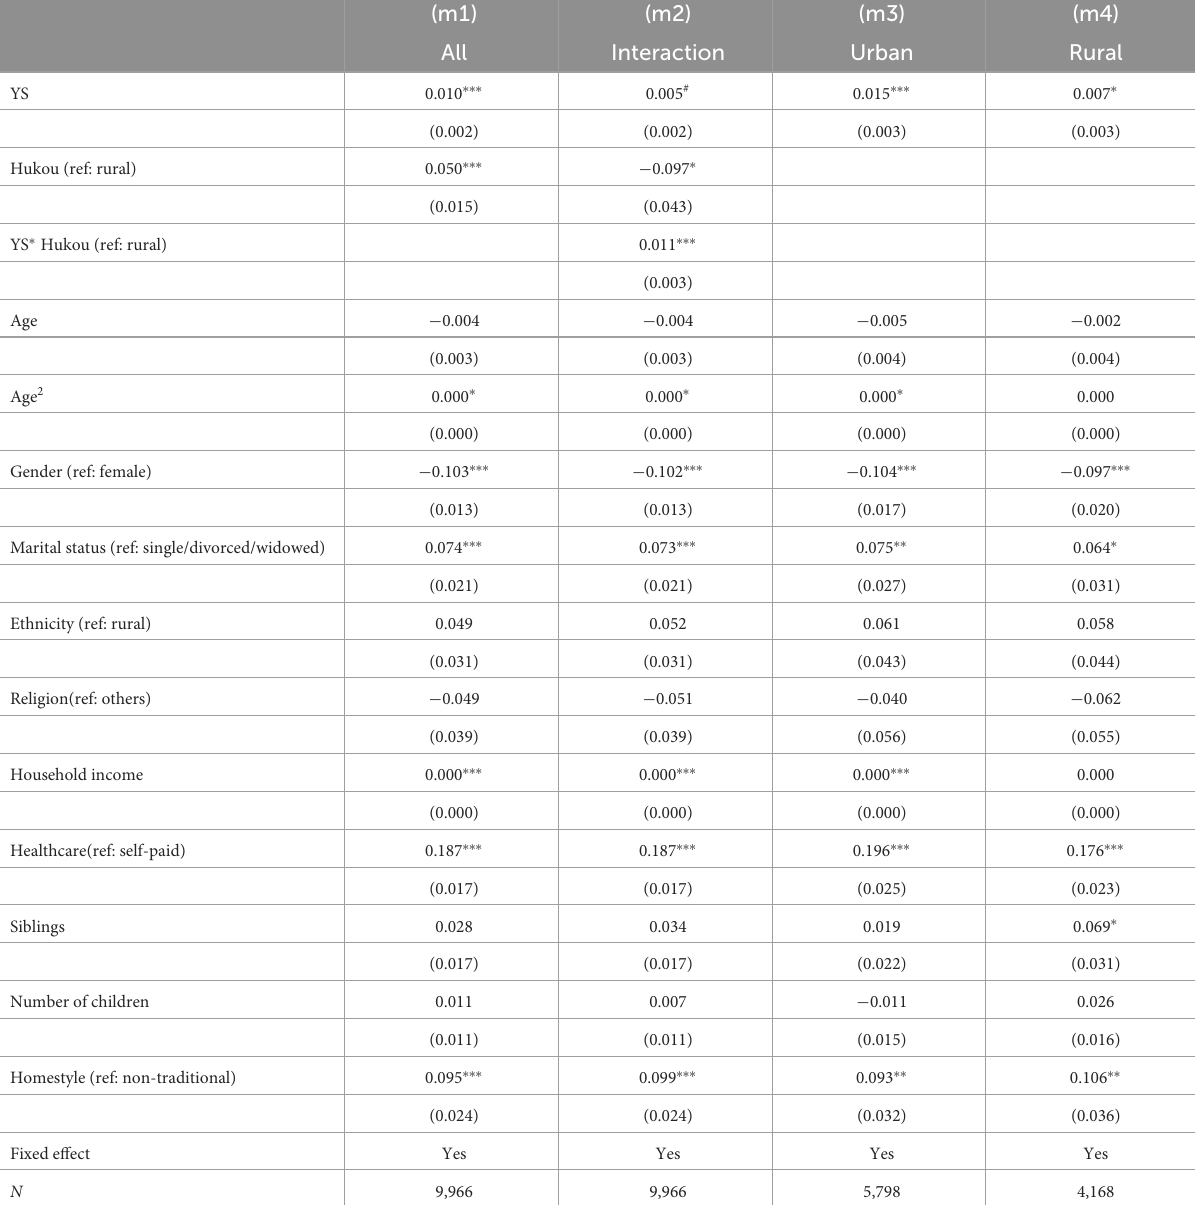
TABLE 2 Effects of YS on FH between urban and rural